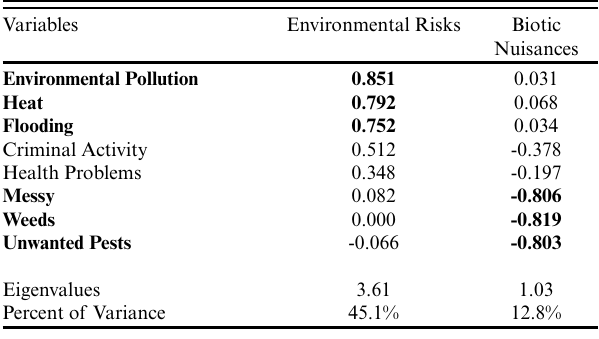
Table 3 . Pattern matrix (loadings) from factor analysis of ecosystem disservice variables. The variables and their significant loadings for each factor are in